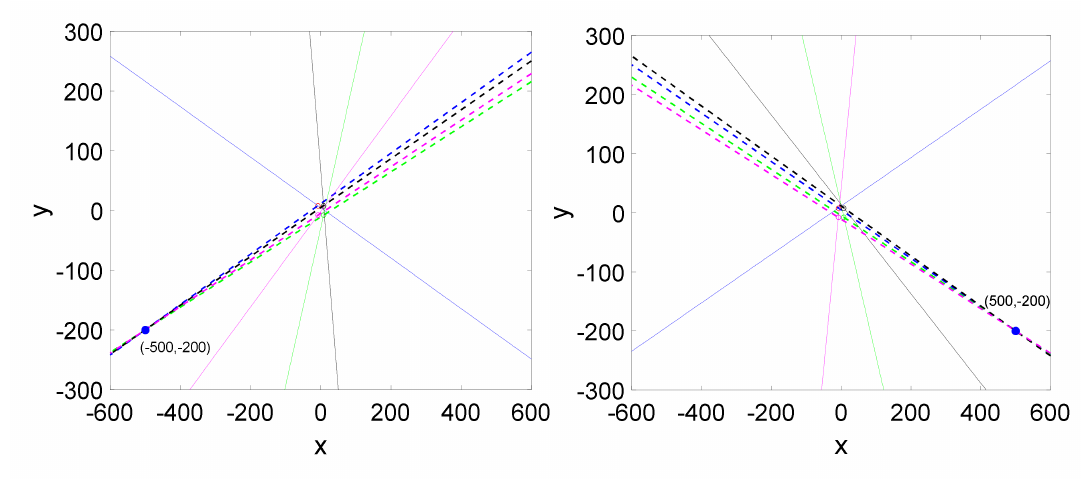
Figure 7. Simulated results of the array hydrophone.